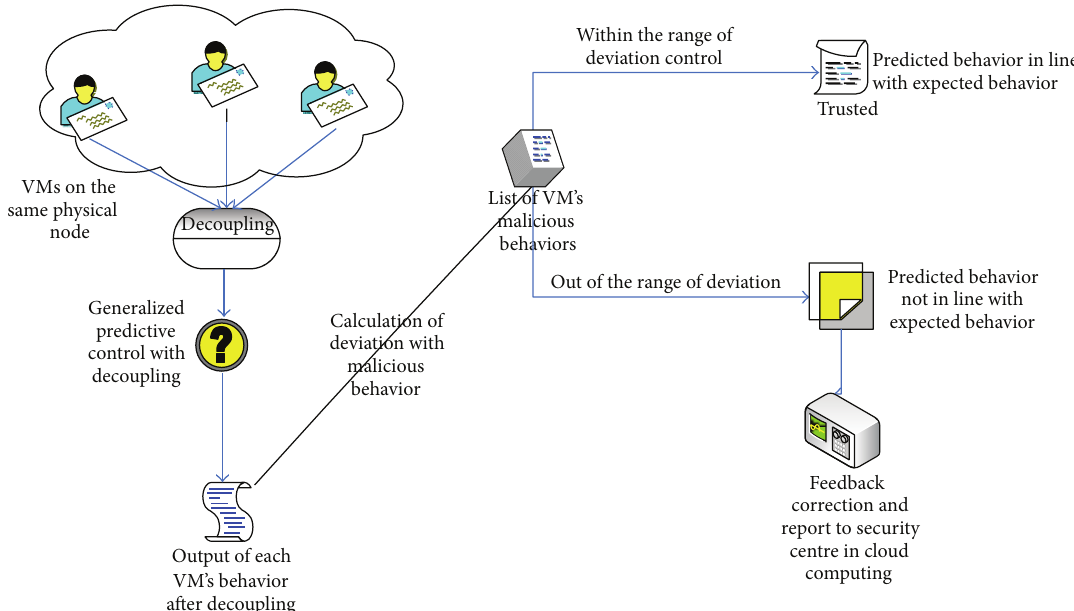
Figure 1: Behavior measurement model of virtual